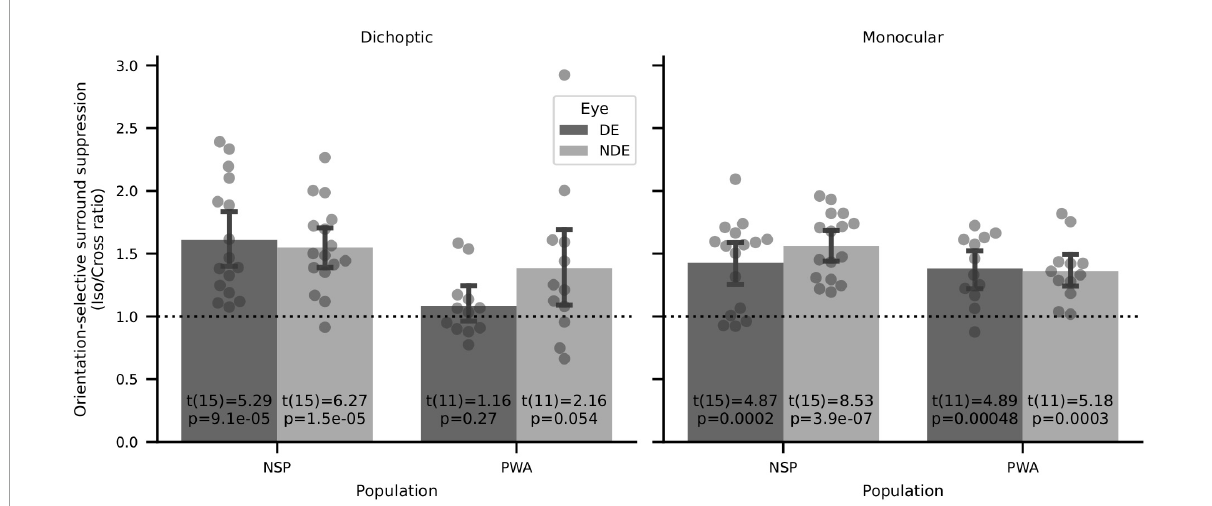
FIGURE10 Orientation-selective surround suppression (OSSS) results. Two-sided one-sample t -tests of iso/cross suppression ratios showed significant OSSS in 6 of 8 conditions, including all four for normally sighted